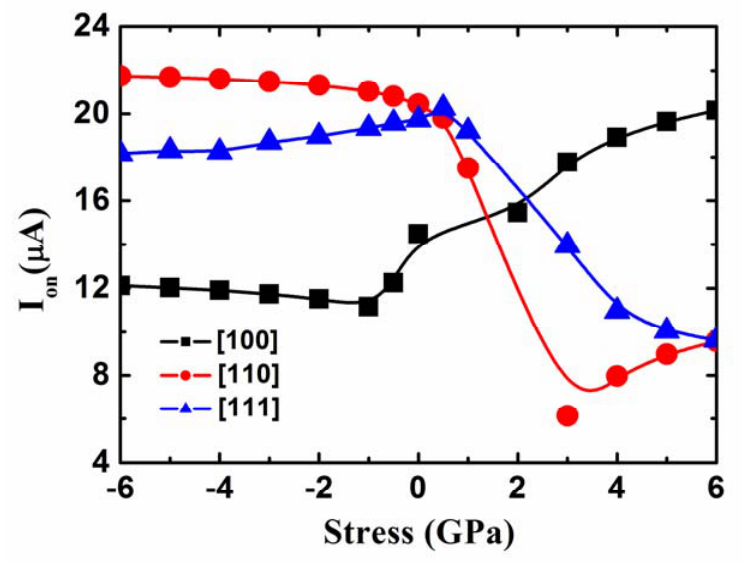
Figure 9. ON-current of the p-type 5 nm square SiNW FETs as a function of the